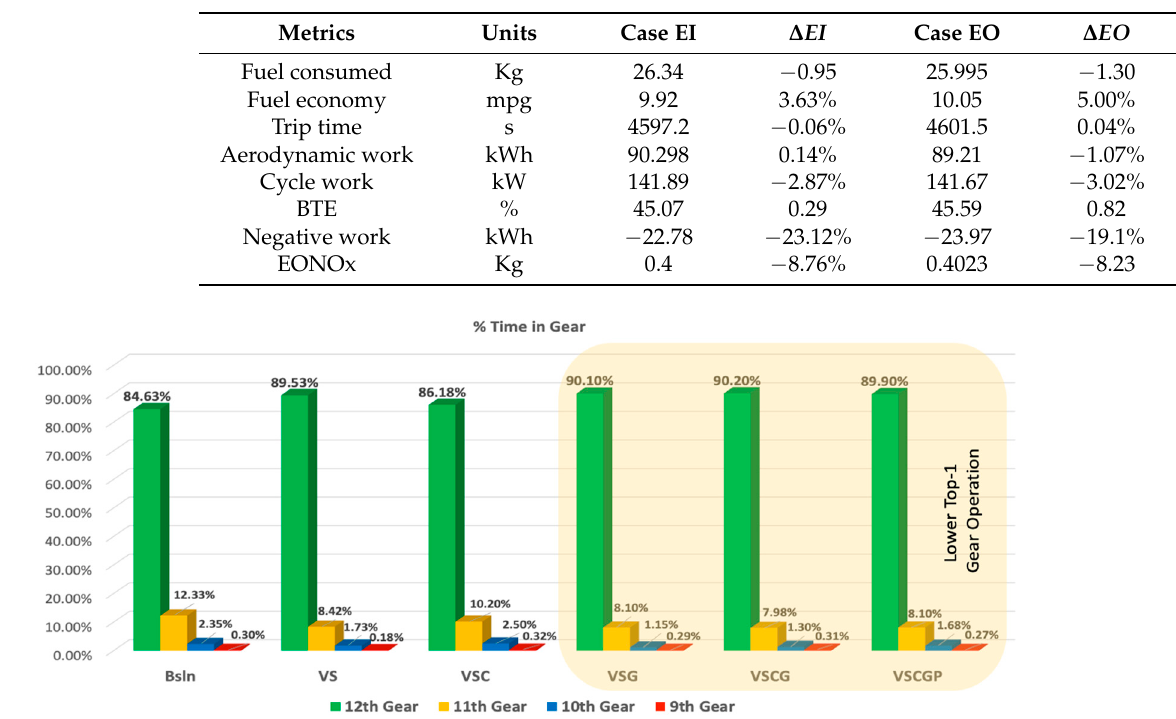
Table 7. Comparison of key metrics for the vehicle speed and coast management problem with engine idle and engine-off condition. The ∆ % is the comparison with the baseline simulation.